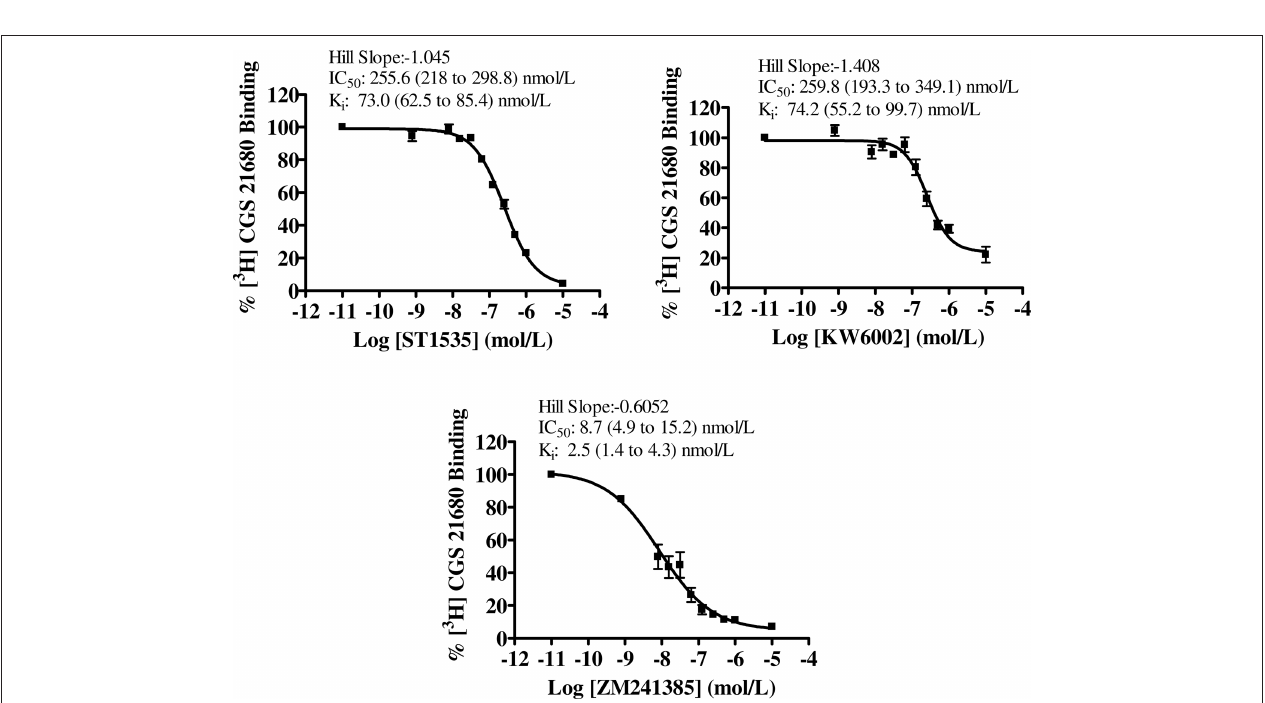
concentrations of compounds and a fixed saturating concentration of CSC. FiGure 3 | Dose–response curve of compound-mediated displacement of Non-specific binding was determined with 100 μM 2-chloroadenosine. Curves [ 3 H]CGS21680 binding to rat striatum in the presence of 200 nmol/L CSC, were obtained from three independent experiments performed in duplicate. to isolate atypical adenosine A receptors. The ordinates represent the 2A Values in brackets represent 95% confidence specific binding of 30 nmol/L [ 3 H]CGS21680 in the presence of different